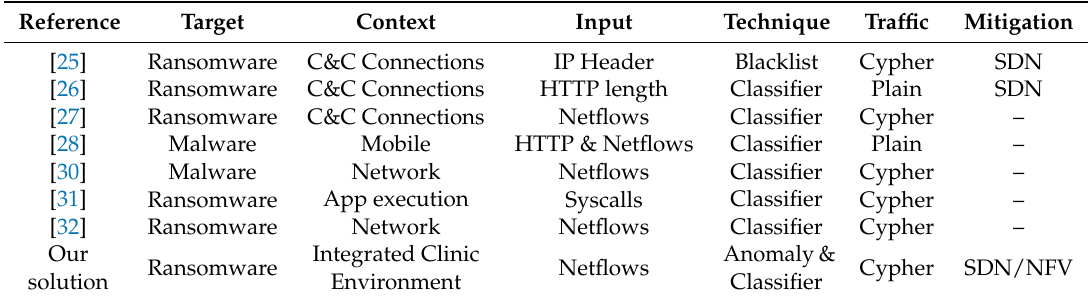
Table 1. Comparison of our work with other relevant